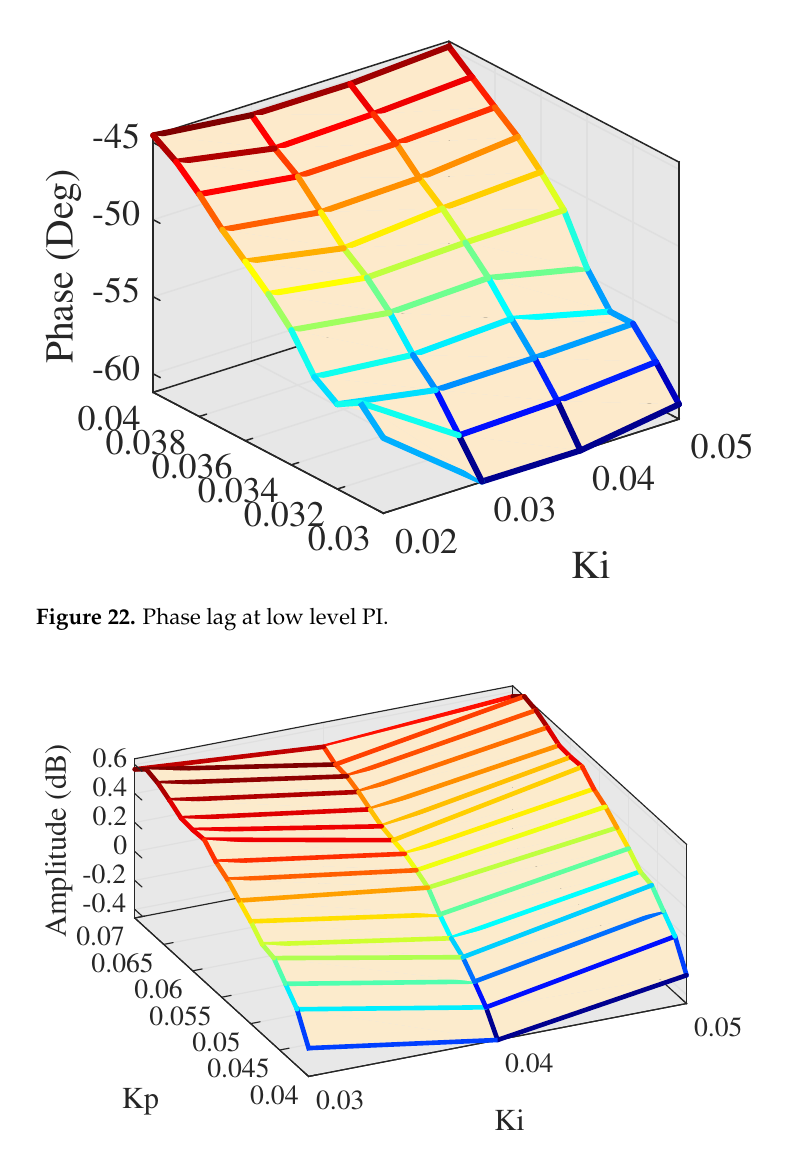
Figure 23. Amplitude at middle level PI.